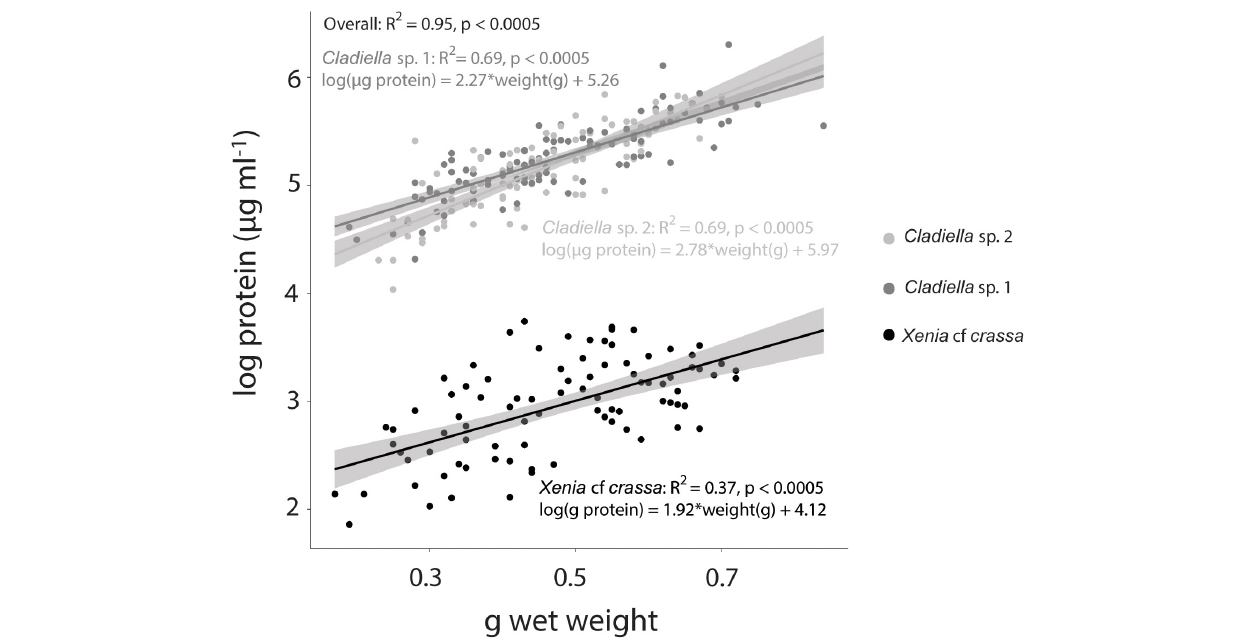
FIGURE 2 | Tissue wet weight vs. log protein concentration in three species of octocoral. Linear model lines of best fit with 95% confidence intervals are represented for each species in the same colour as the scatter points.